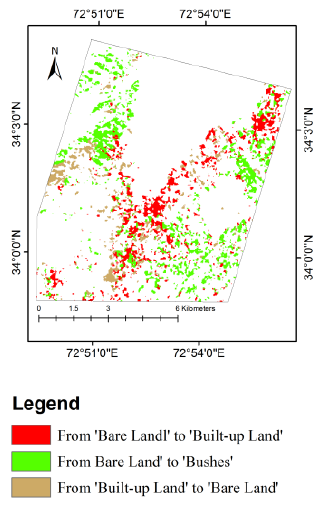
Figure 4. Change detection results of OLI SVM classified data from winter to autumn